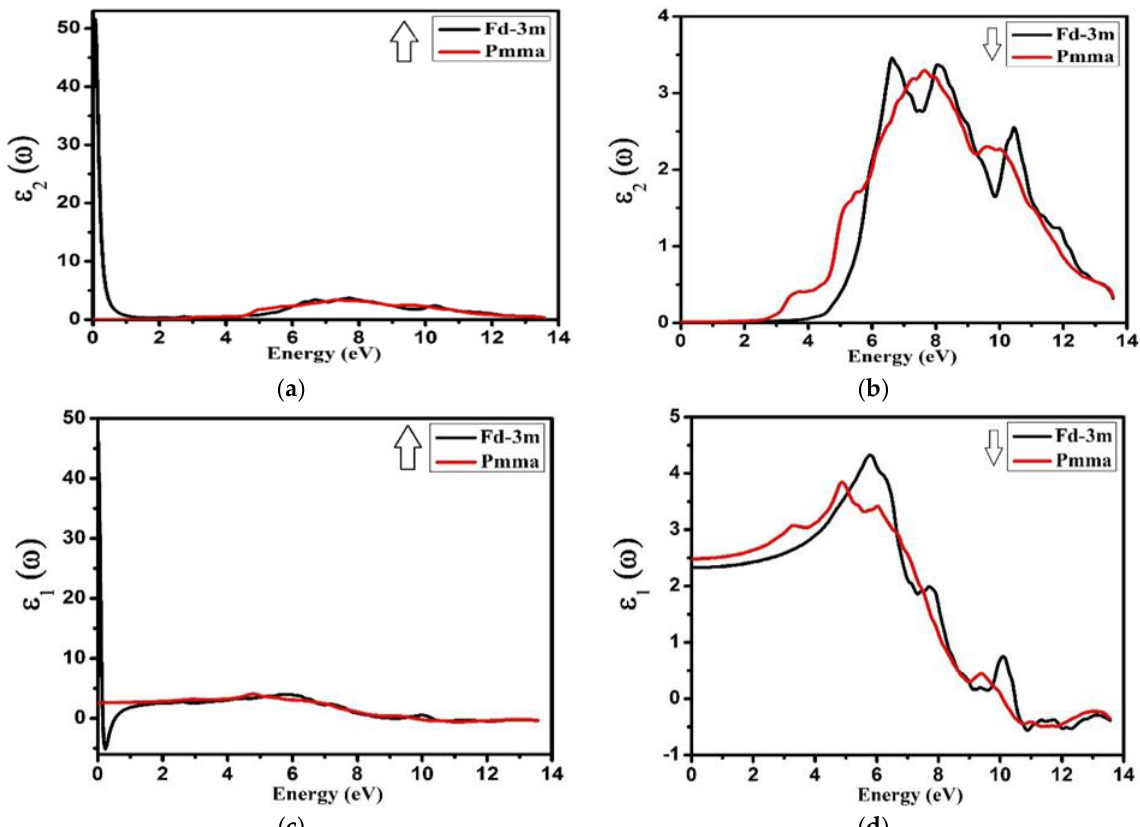
Figure 7. ( a , b ) The imaginary part, ε 2 (ω) , of the complex dielectric function for Nd 2 Zr 2 O 7 and ( c , d ) the real part, ε 1 (ω) , of the complex dielectric functions for Nd 2 Zr 2 O 7 ((black color for Fd-3m) and (red color for Pmma)) using GGA+U ( a , c ) for the spin-up direction ( ↑ ) and ( b , d ) spin-down ( ↓ ) direction.